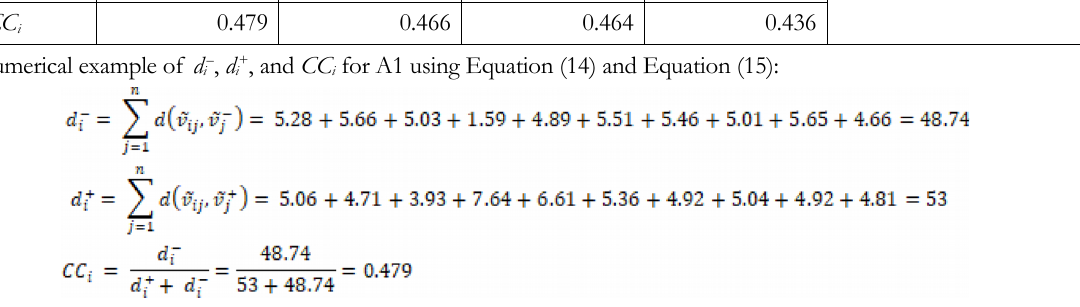
Table 13. Closeness Coefficient ( CC